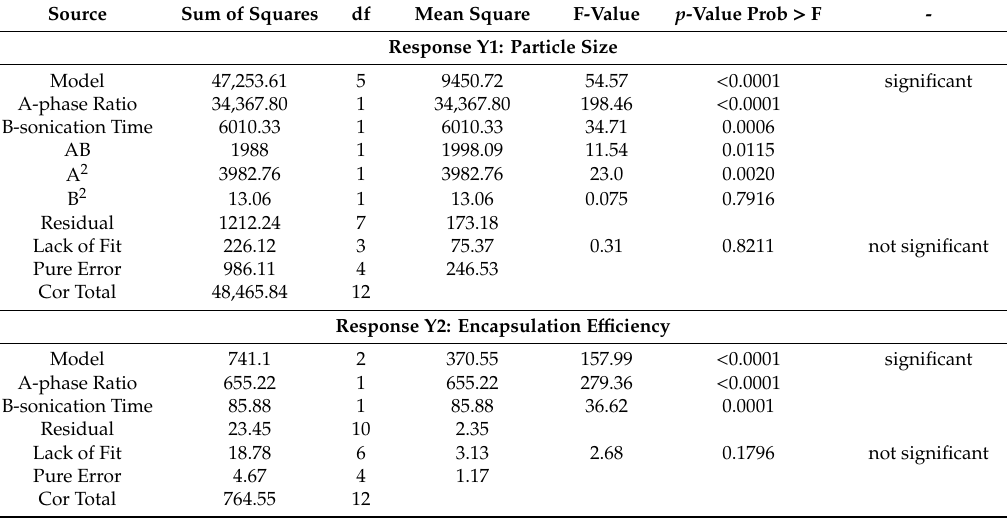
Table 4. Analysis of variance of responses of particle size (Y1) and encapsulation e ffi ciency